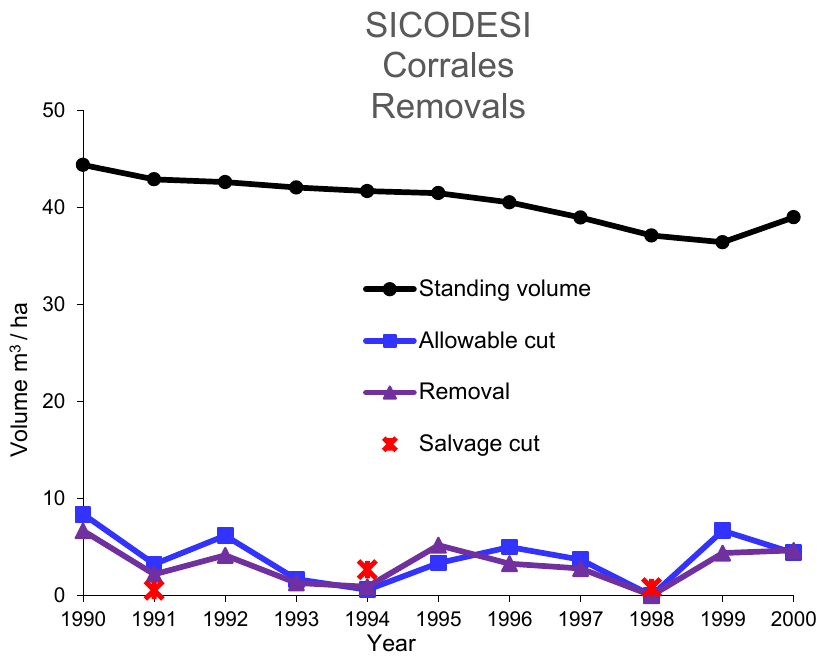
Figure 5. Harvest output in Comunidad Indígena Santa Cruz del Tuito, managed with Plan Costa.